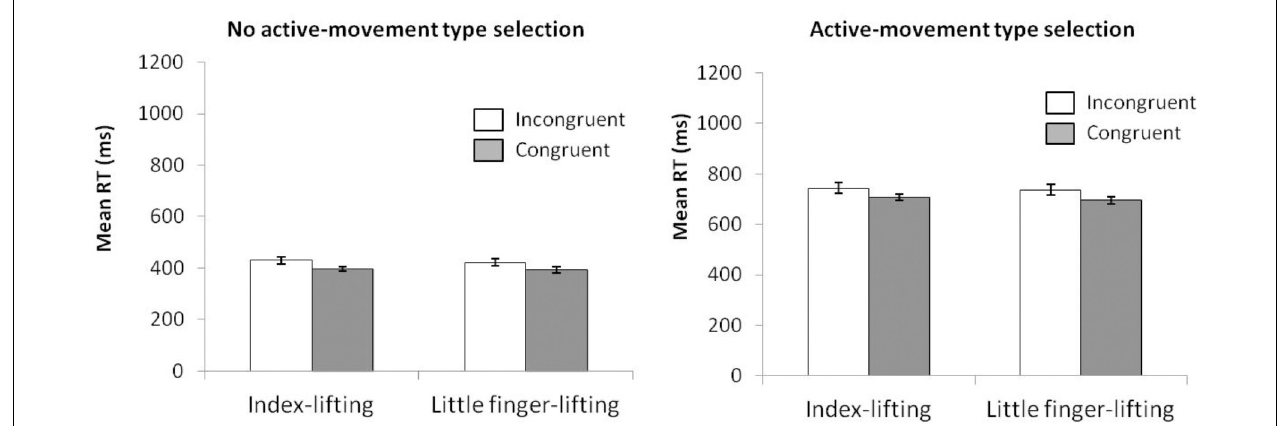
FIGURE 10 | Interactions of movement type selection × movement complexity × congruence, within the no active-movement type selection condition (Left) and active-movement type selection (Right) , with respect to mean reaction time in Experiment 4. Error bars represent the standard error of the mean.